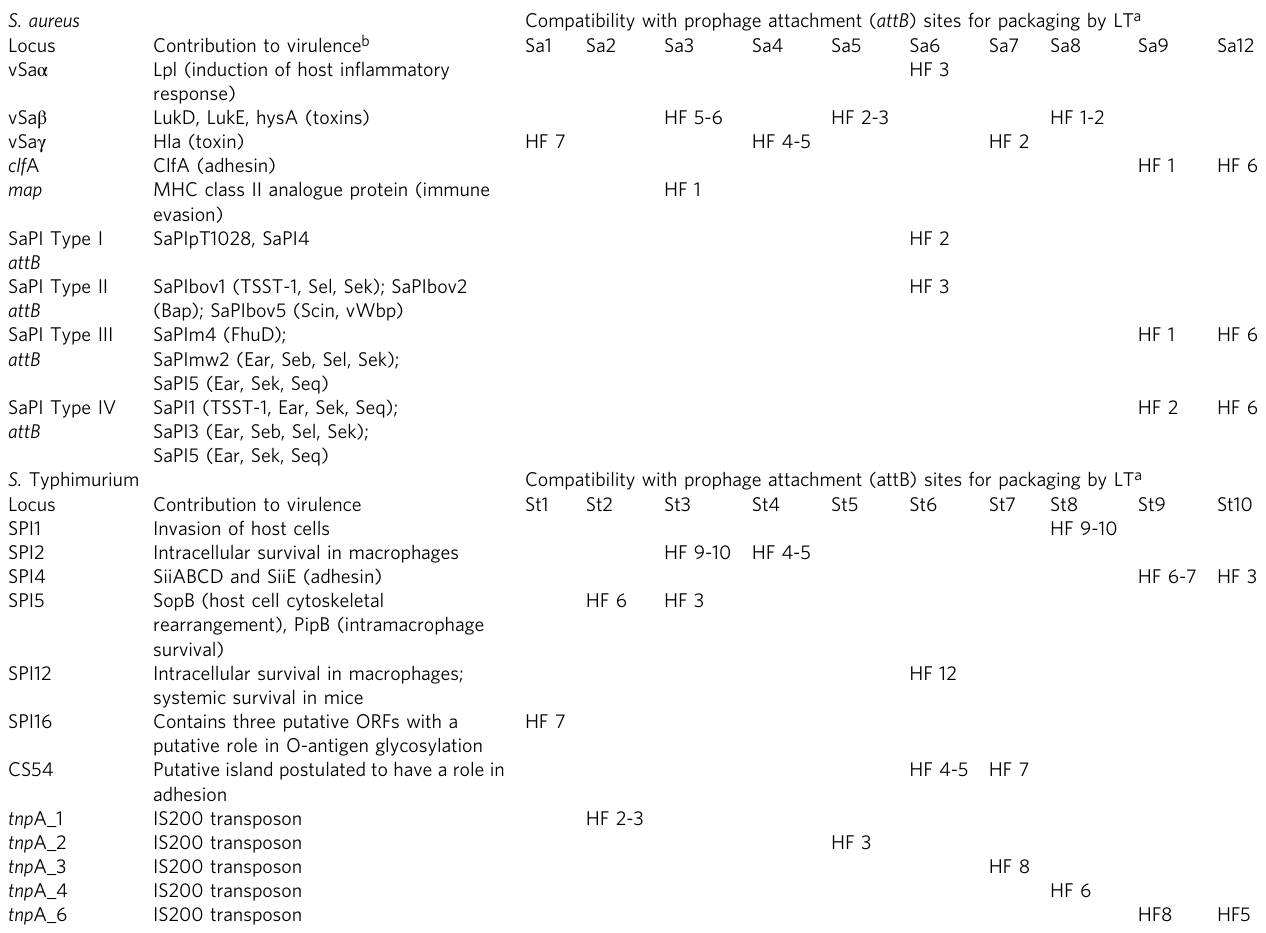
Table 4 Examples of virulence-associated loci compatible with transfer via LT. S.